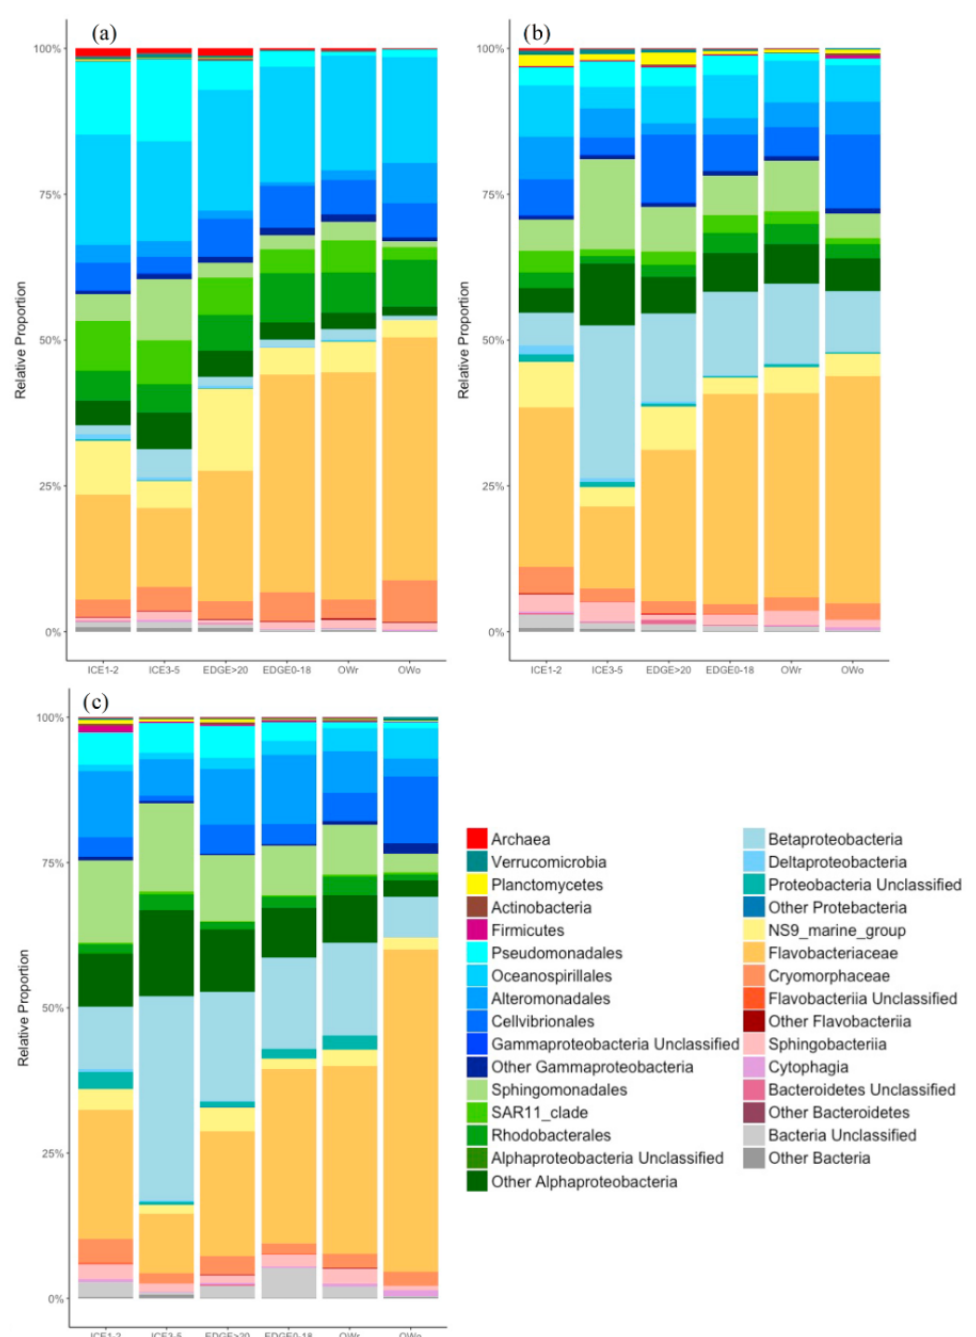
Figure 10. Relative proportions of the different microbial taxa within the different groups of samples: (a) for the 0.2–3µm size fraction (free-living bacteria); (b) for the 3–20µm size fraction (particle-attached bacteria); and (c) for the size fraction > 20µm (particle-attached bacteria). ICE1-2: ice stations in the transects 100 and 200; ICE3-5: ice stations in transects 300 and 500; EDGE0-18: samples between 0 and 18m depth from the edge stations (stations 107, 204, and 312); EDGE > 20: samples greater than 20m deep from the edge stations (stations 107, 204, and 312); OWr: open water stations where the ice had receded between 2 and 8d previously; OWo: open water stations where the ice has receded more than 15d previously.